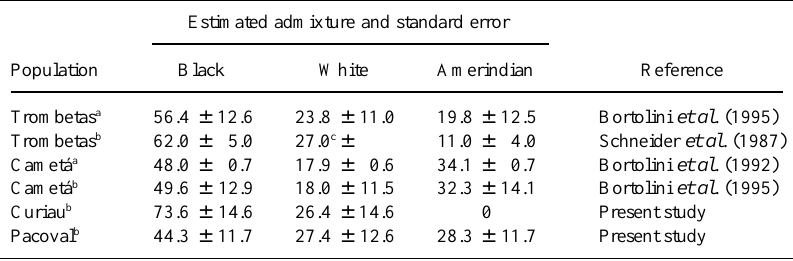
Table III - Interethnic admixture in Afro-Brazilian populations from the Amazon region